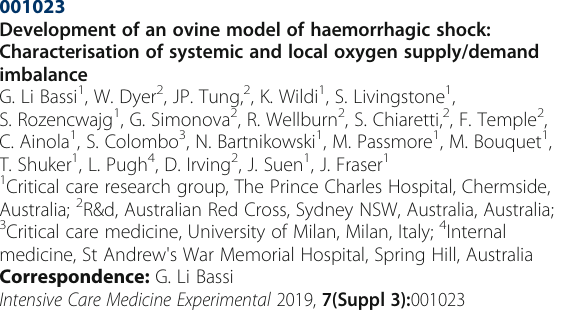
Table 1 (abstract 001023). See text for description